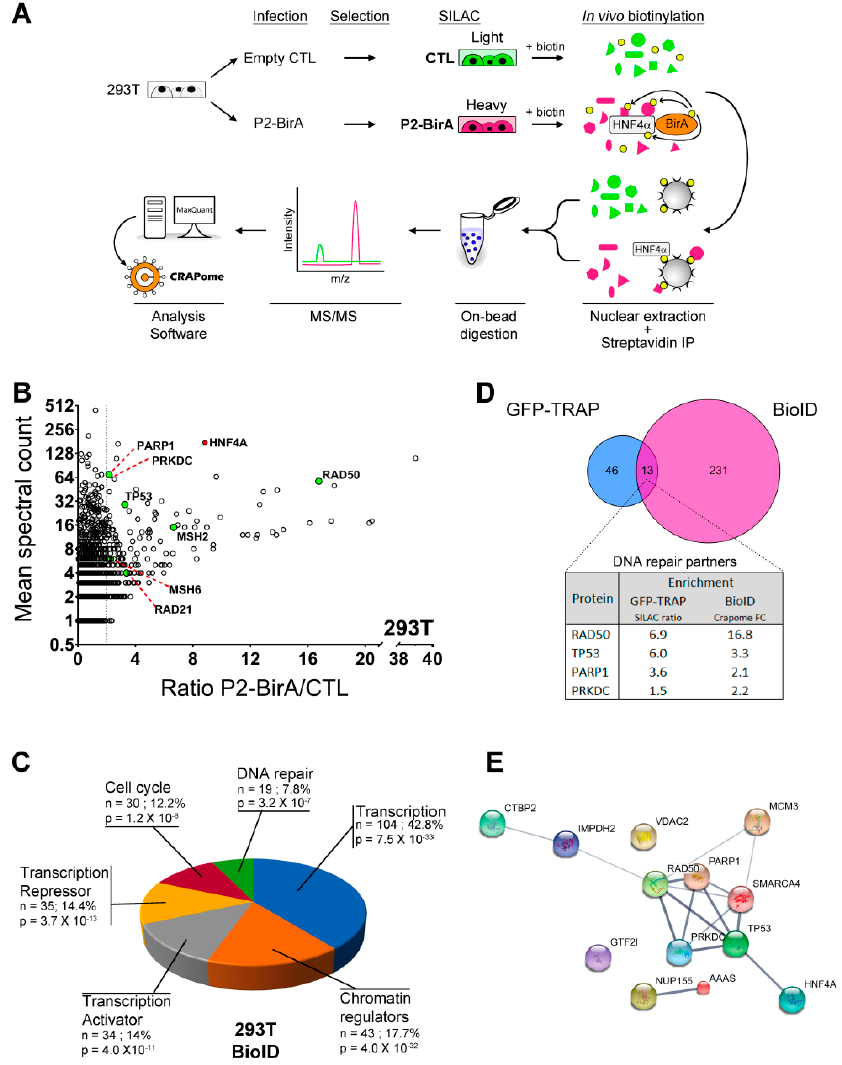
Figure 3. BioID analysis confirms interaction of P2-BirA with DNA damage proteins in HEK293T cells. ( A ) Experimental design of the BioID technique used to label in vivo interacting partners of P2- BirA. HEK293T cells were infected using lentivirus expressing a construct of HNF4 α tagged in